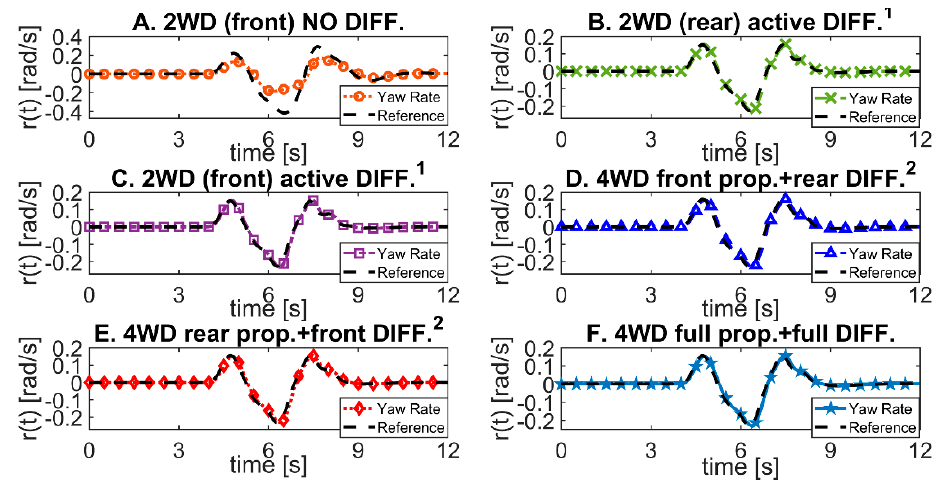
Figure 11. DLC Maneuver: yaw-rate tracking ( 𝑟 ): ( A ) 2WD (front) NO DIFF.{ 𝑑⃗ ((cid:3032)) }; ( B ) 2WD (rear) active DIFF.{ 𝑑⃗ ((cid:3029)) }; ( C ) 2WD (front) active DIFF. { 𝑑⃗ ((cid:3034)) }; ( D ) 4WD front prop.+rear DIFF. { 𝑑⃗ ((cid:3033)) }; ( E ) 4WD rear prop.+front DIFF. { 𝑑⃗ ((cid:3030)) }; ( F ) 4WD full prop.+full DIFF.{ 𝑑⃗ ((cid:3039)) }. [ 1 (B{ 𝑑⃗ ((cid:3029)) },C{ 𝑑⃗ ((cid:3034)) }) and 2 (D{ 𝑑⃗ ((cid:3033)) },E{ 𝑑⃗ ((cid:3030)) }) are dual layouts].